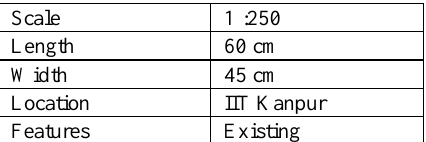
Table 1. Parameters of Selected Model for conduct of